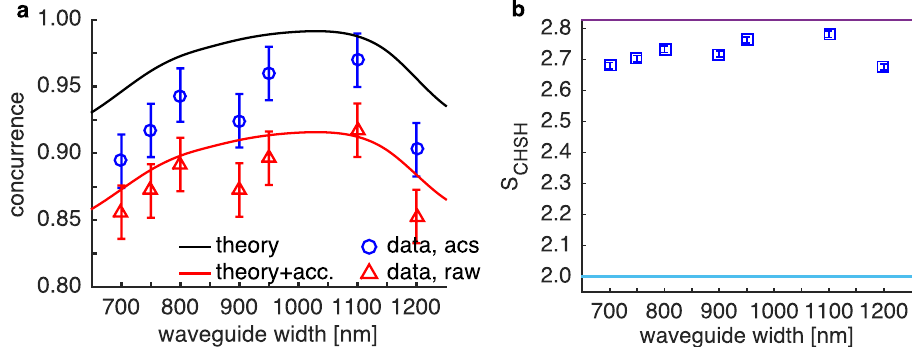
Figure 5. ( a ) The experimental and simulated concurrences of the generated states versus waveguide widths. The higher concurrence shown has the accidental counts subtracted while the lower concurrence shown is based on raw experimental data. ( b ) The expected S parameter extracted from the reconstructed density matrix showing a violation of the Bell-CHSH inequality. The torquise line is the classical correlation limit whereas the magenta line marks the quantum correlation limit.